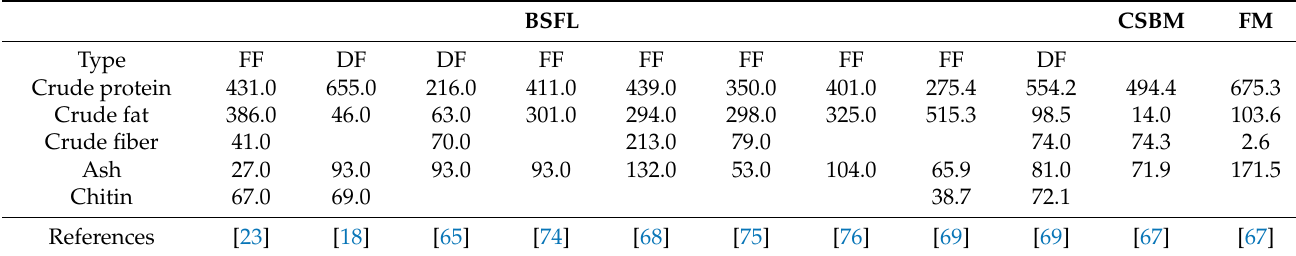
Table 1. Regular nutrition facts of BSFL (g kg − 1 dry matter basis).